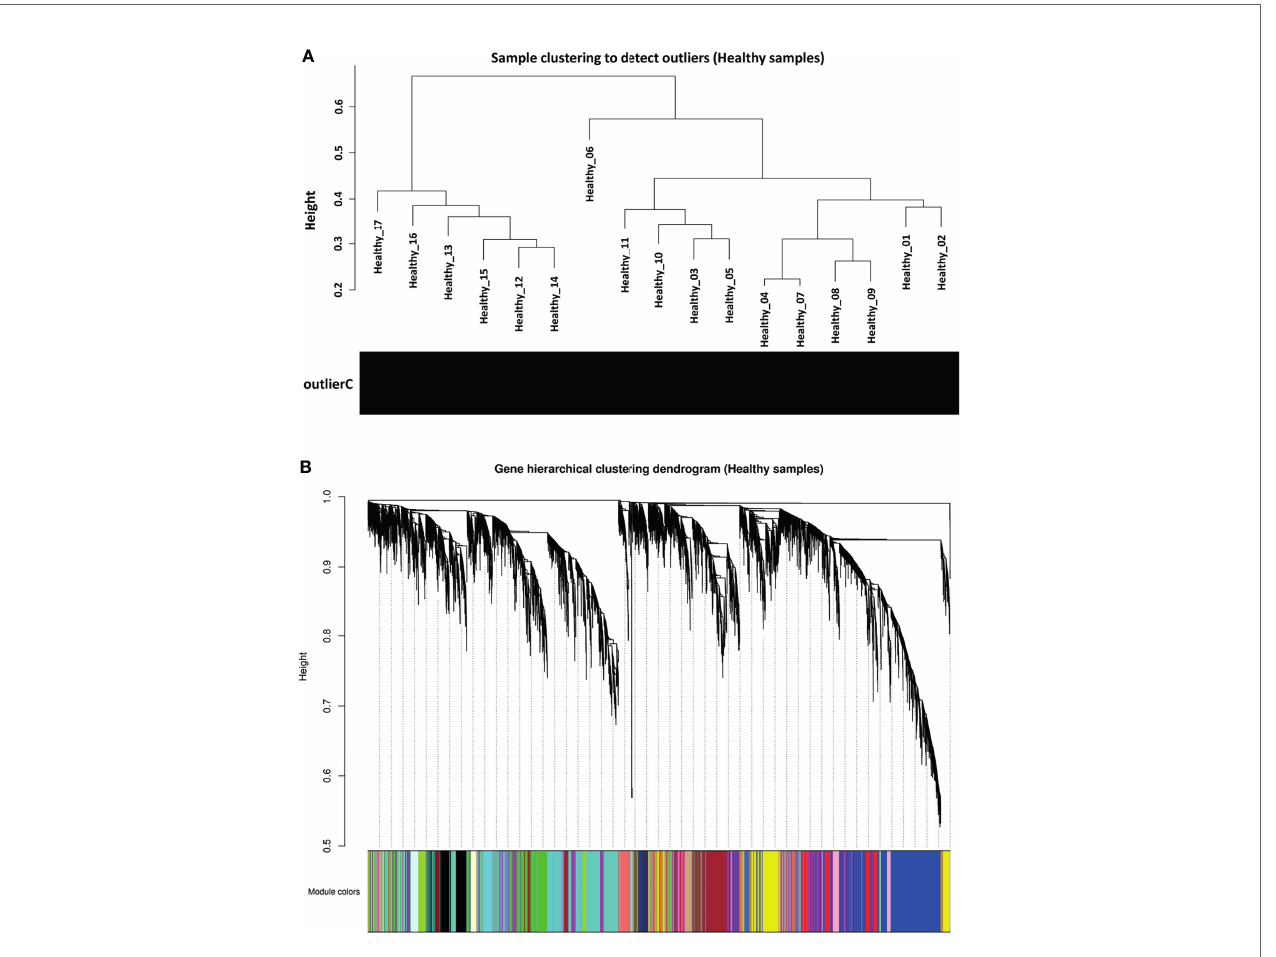
FIGURE 2 | Preprocessing of weighted gene co-expression network analysis. (A) Sample clustering to detect outliers in healthy samples as reference set. All samples had a standardized connectivity score > − 2.5. (B) Gene hierarchical clustering dendrogram of 21 detected modules based on a dissimilarity (1-TOM) measure. Branches represent modules that are marked with a speci fi c color. The y-axis represents the co-expression distance, the x-axis represents genes and the grey module represents background